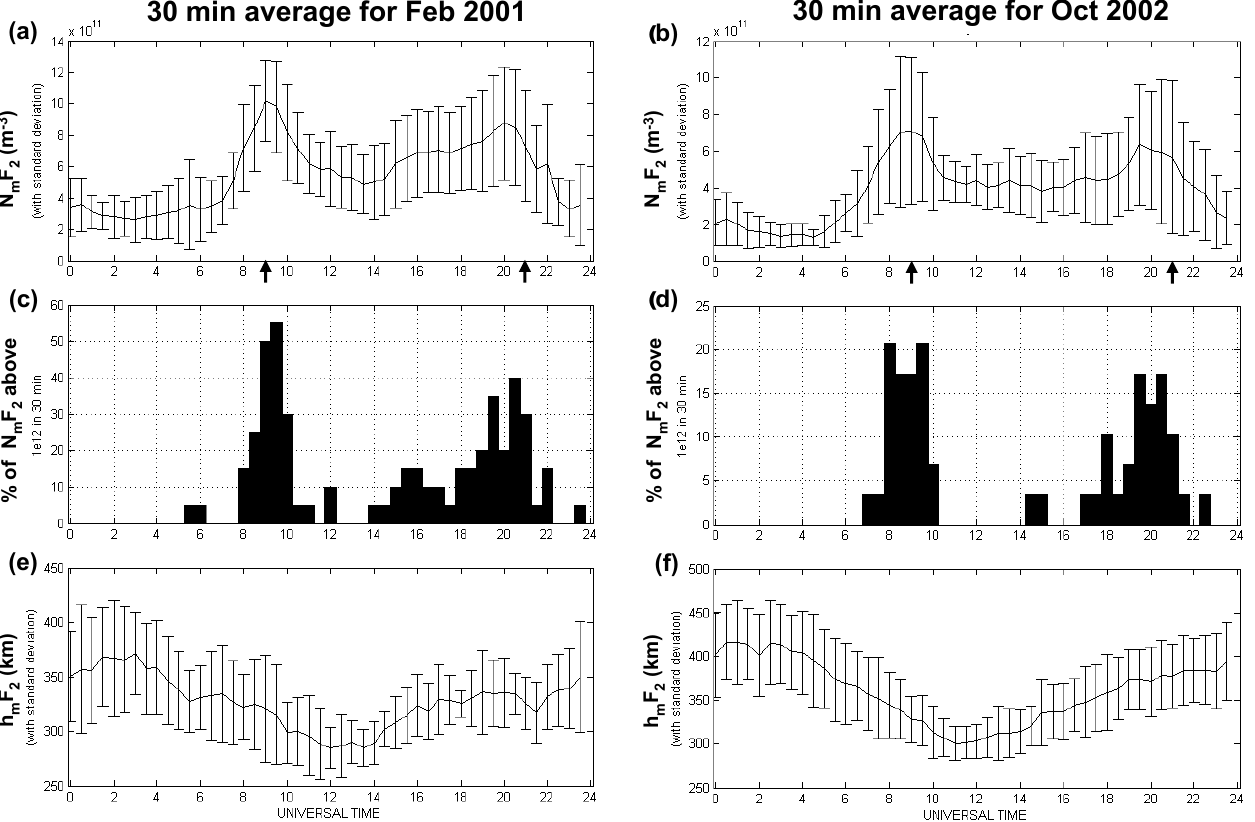
Fig. 1. (a–b) Averaged F2 region peak electron density versus time UT for long duration runs by EISCAT Svalbard Radar in February 2001 and October 2002. Magnetic noon ( ∼ 09:00MLT) and magnetic midnight ( ∼ 21:00MLT) are indicated by arrows on the time axis. The curves represent 30min averaged data over each month, and the bars represent one standard deviation in the N m F 2 data. (c–d) The percentage of extreme densities ( N m F 2 > 10 − 12 m − 3 ) observed in the two data set versus time. (e–f) 30min averages of altitude of the F2 region peak corresponding to panels (a) and (b). The bars represent one standard deviation spread in h m F 2